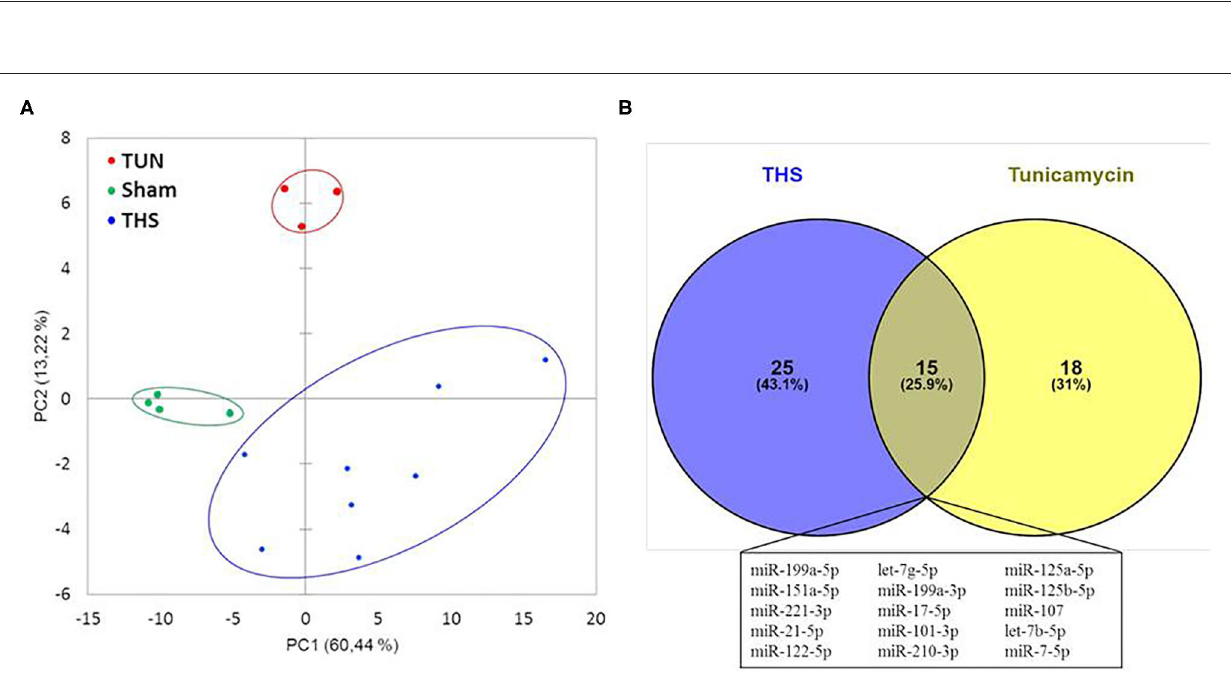
Frontiers in Medicine |